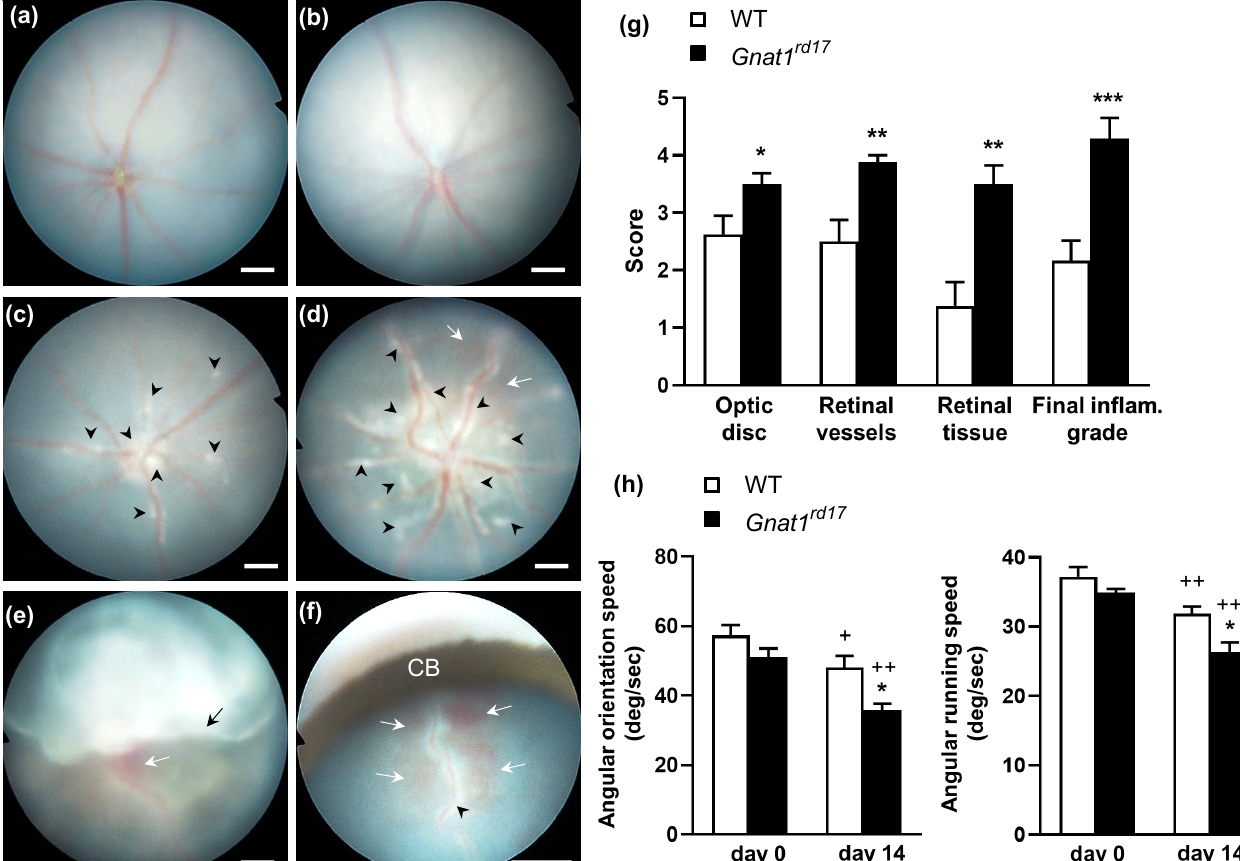
Figure 1. Gnat1 rd17 mice exhibit exacerbated EAU. Fundus images of normal 9-week-old ( a ) WT and ( b ) Gnat1 rd17 mice before EAU induction. Fundus images of EAU ( c ) WT and ( d – f ) Gnat1 rd17 mice taken on day 14 after immunization. Gnat1 rd17 mice with EAU showed signs of hemorrhage (white arrows) and more inflammatory infiltrates (black arrowheads) in the retina than EAU WT mice. ( e ) Fundus image of EAU Gnat1 rd17 mouse with severe retinal detachment (black arrow) on day 14 after immunization. ( f ) Magnification of the peripheral retina shows vessel hemorrhage and severe perivascular inflammatory infiltrates observed in EAU Gnat1 rd17 mice on day 14 after